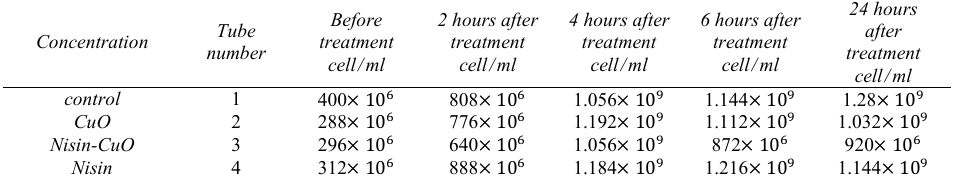
Table 7: Mean optical densities reflecting antimicrobial activity shown by CuO, nisin, and nisin-conjugated CuO NPs at the same (30μg/mL) concentration Tube Concentration number